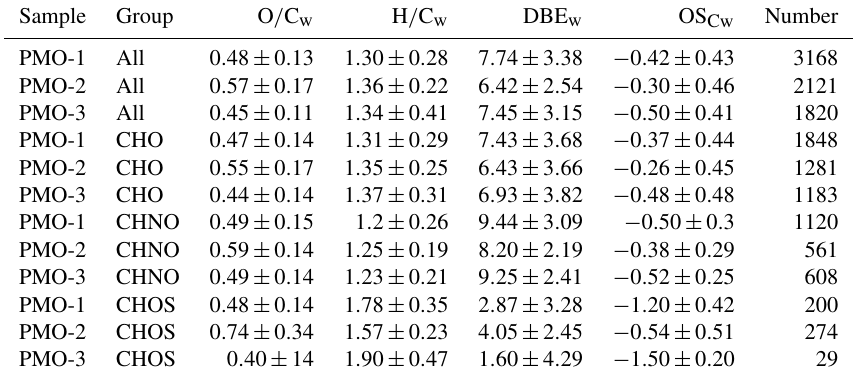
Table 2. Molecular formula composition with abundance-weighted average values and the numbers of formulas for each elemental group. Sample